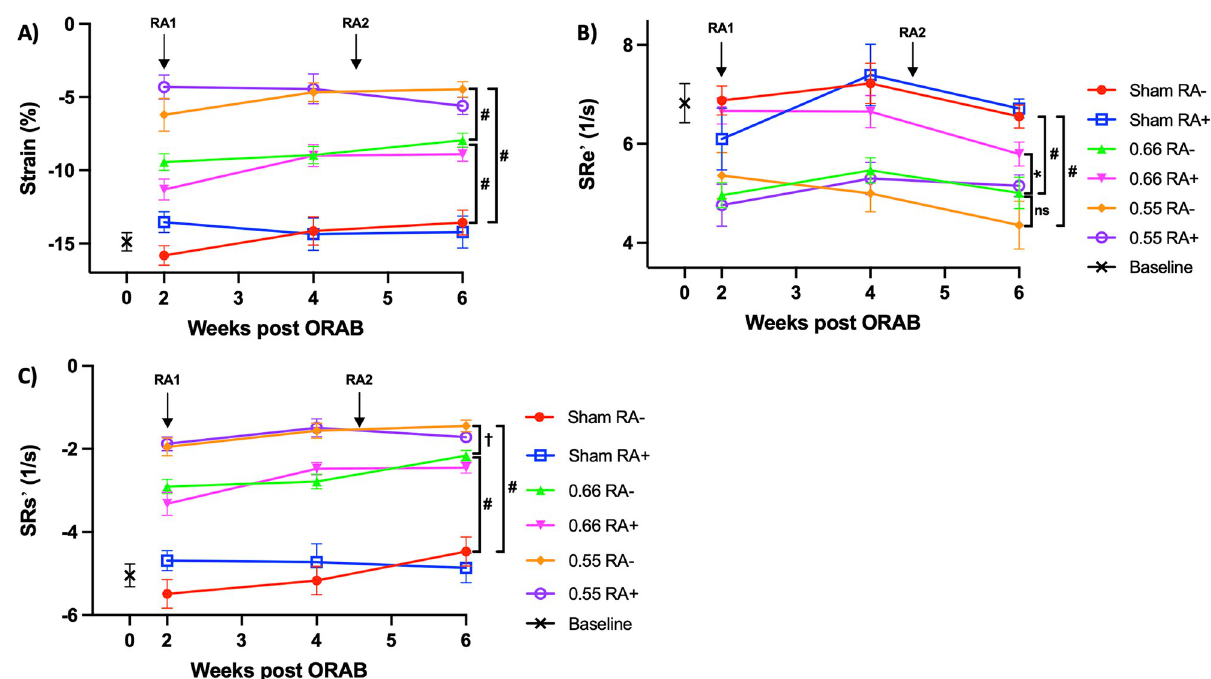
Fig 5. Analysis of heart function parameters by TPM-MRI. MRI assessed LV strain (%, panel A), strain rate e’ (panel B; SRe’, peak early diastolic strain rate) and strain rate s’ (panel C; SRs’, peak systolic strain rate) in septum and LV free wall combined at given time points (n = 42 in total, 7 in each group). Values are mean ± SEM. RA1 = time of establishment of RA phenotype with a sc. injection of mBSA, RA2 = time of reestablishment of RA with an additional injection with mBSA. Statistical significance was calculated using two-way ANOVA with Bonferroni’s multiple comparisons test. ns = non-significant, � P < 0.05, † P < 0.01; ‡ P < 0.001, # P < 0.0001. MRI, magnetic resonance imaging; LV, left ventricular; mBSA, methylated bovine serum albumin.